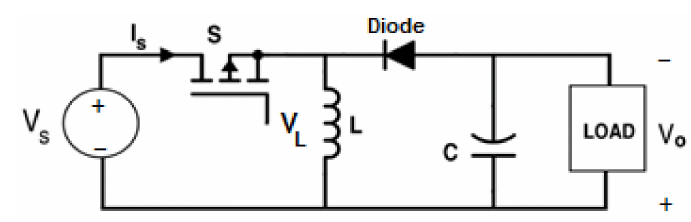
Figure 5. The single-switch buck–boost converter.